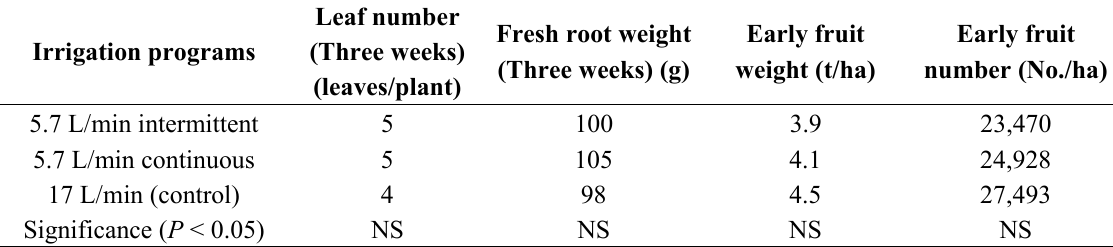
Table 3. Effects of irrigation programs on the leaf number, fresh root weight and early fruit weight and number (first eight harvests) during the establishment of bare-root strawberry transplants in Balm, FL, USA, during the 2011–2012 season. NS = non-significant at P <